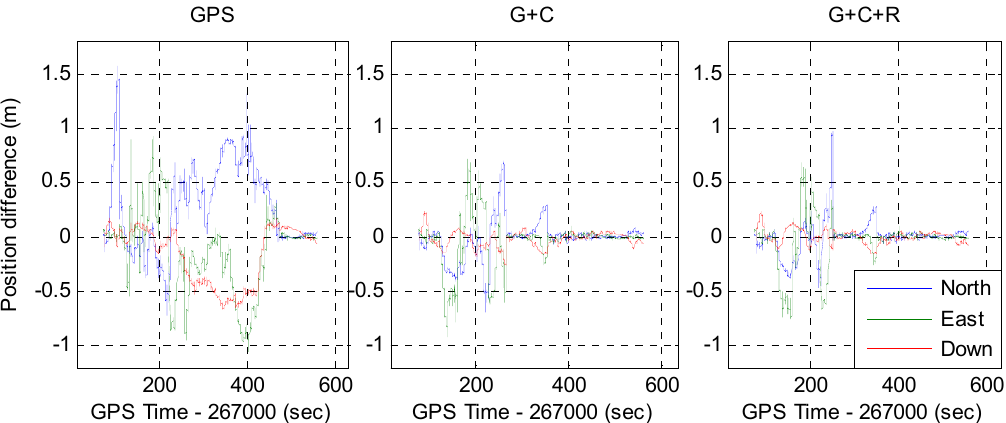
Figure 9. Position difference of the tightly coupled RTK/INS integration with respect to the reference for the GPS, GPS + BDS (G + C), and GPS + BDS + GLONASS (G + C + R) systems.